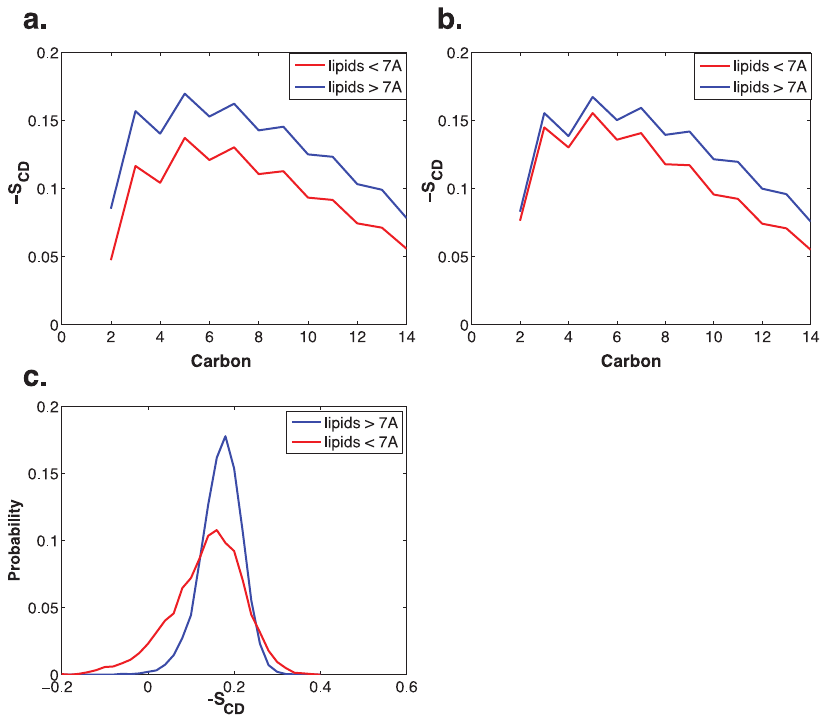
Figure 3. Fusion-active peptides induce decreased acyl tail order in nearby lipids. Calculated carbon-deuterium order parameters are plotted for sn-1 acyl tails in (a) for lipid bilayers containing the X-31 fusion peptide and in (b) for bilayers containing the G1V mutant. X-31 peptides induce a significant disordering of lipid tails within 7 A˚ compared to tails in the same leaflet but . 7 A˚. The G1V peptide induces a significantly smaller effect, perhaps related to its lesser promotion of lipid protrusion. Values in (a–b) are averaged over lipids. Plotted in (c) is the distribution of carbon- deuterium order values (sign reversed from panels a–b) for carbon 4 of sn-1 tails in the X-31 simulations. Values show a significant deviation from normality (p , 0.001, Shapiro-Wilk test) with substantial ‘‘tail’’ population of more disordered lipids close to the peptide. The Pearson correlation coefficient between calculated SCD parameters in the X-31 simulations and experimentally measured parameters [47] is 0.92.